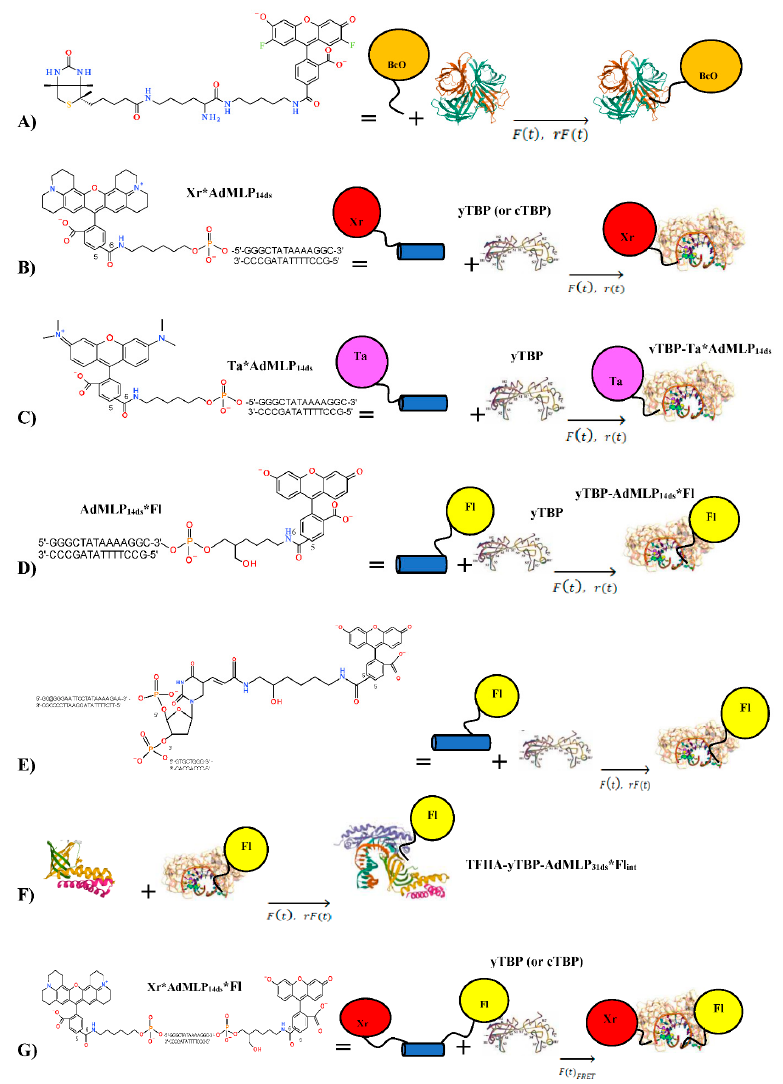
Figure 1. Stopped-flow association reactions monitored by r(t) , F(t) , rF(t) , and F(t) FRET sensing modalities. ( A ) The Oregon Green ® Biocytin (BcO) is attached through 18 non-hydrogen atoms as a spacer between the carboxy-dye and biotin ring structure, which binds to one of the four sites of avidin (AV) [43] under pseudo-first-order condition (or > 10 × binding site excess) [44]. ( B – G ) The Adenovirus Major Late promoter duplexed probes (AdMLP ds , Table 1) are bound and bend by TATA-